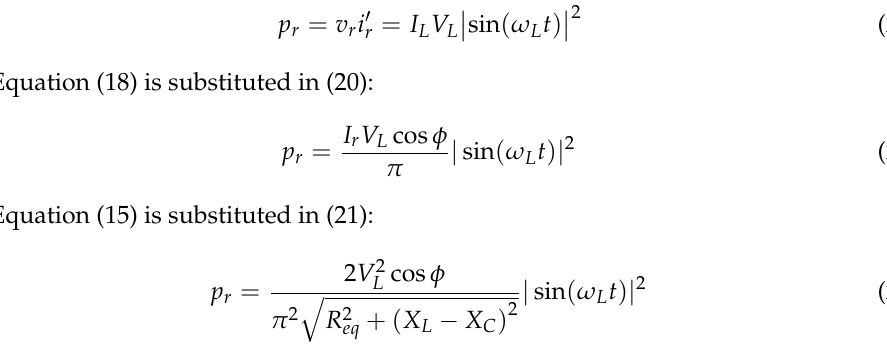
ered by the rectifier at a low frequency, which is defined as